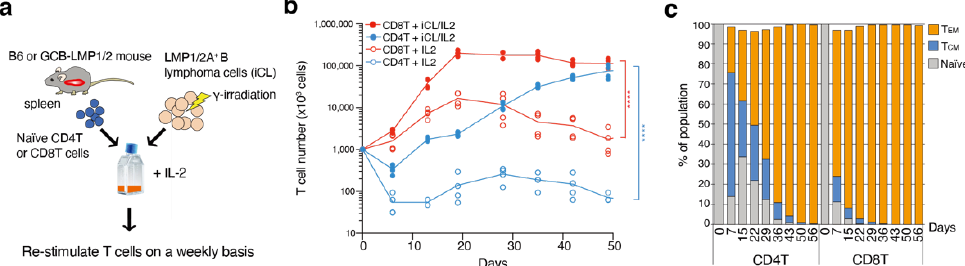
Figure 1. LMP1/2A + B lymphoma cells induce T cell activation, expansion, and effector differ- entiation. ( a ) Workflow of in vitro LMP1/2A + B cell-specific T cell culture. ( b ) Cell number of in vitro cultured CD4 + T cells or CD8 + T cells from C57BL/6 (B6) mice in the presence or absence of γ -irradiated LMP1/2A + B lymphoma cells (iCL). Results from two to four biological replicates